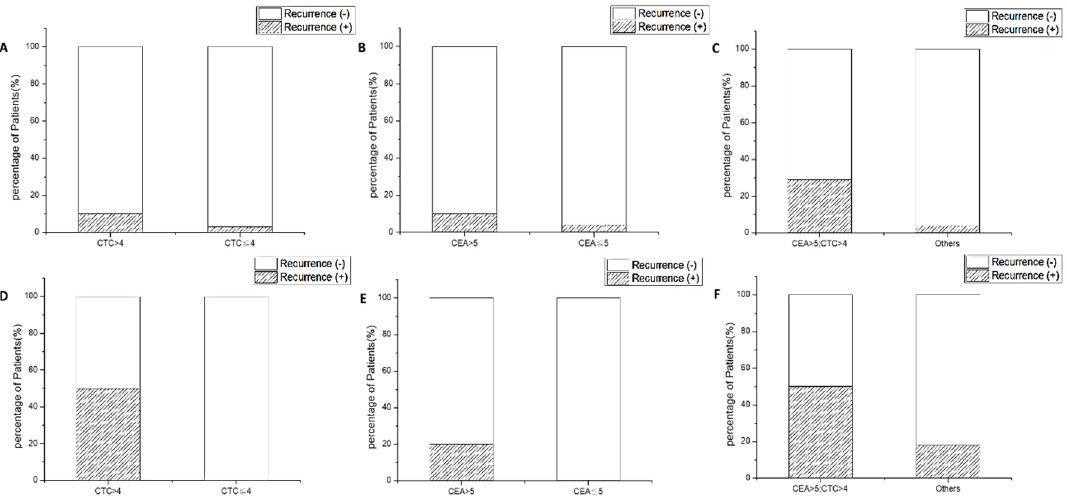
Figure 4. The recurrence rates in patients stratified by their CTC and carcinoembryonic antigen (CEA) counts, and their combination. ( A ) Recurrence rates of different CTC levels in non-metastatic patients; ( B ) recurrence rates of different CEA levels in non-metastatic patients; ( C ) recurrence rates of different CTC and CEA levels in non-metastatic patients; ( D ) recurrence rates of different CTC levels in metastatic patients; ( E ) recurrence rates of different CEA levels in metastatic patients; ( F ) recurrence rates of different CTC and CEA levels in metastatic patients. Table 3. Odds ratios (ORs) of CTC, CEA, and their combination to predict recurrent events. Data from patients with non-metastatic CRC are listed in (A), and data from patients with metastatic CRC are listed in (B). N/A: not analyzable due to absence of recurrent event. (A)